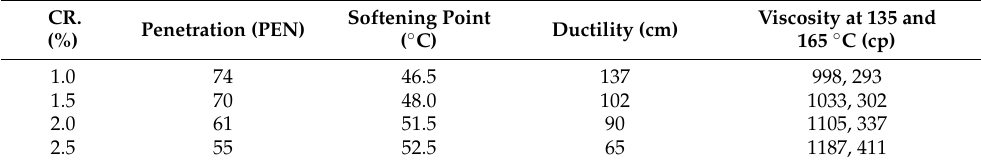
Table 5. Trials to determine the optimum crumb rubber content for the 40% RAPB + 4.6% WFO.